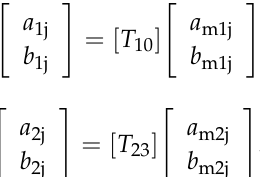
Figure 1. Error model of a two-port vector network analyzer (VNA).